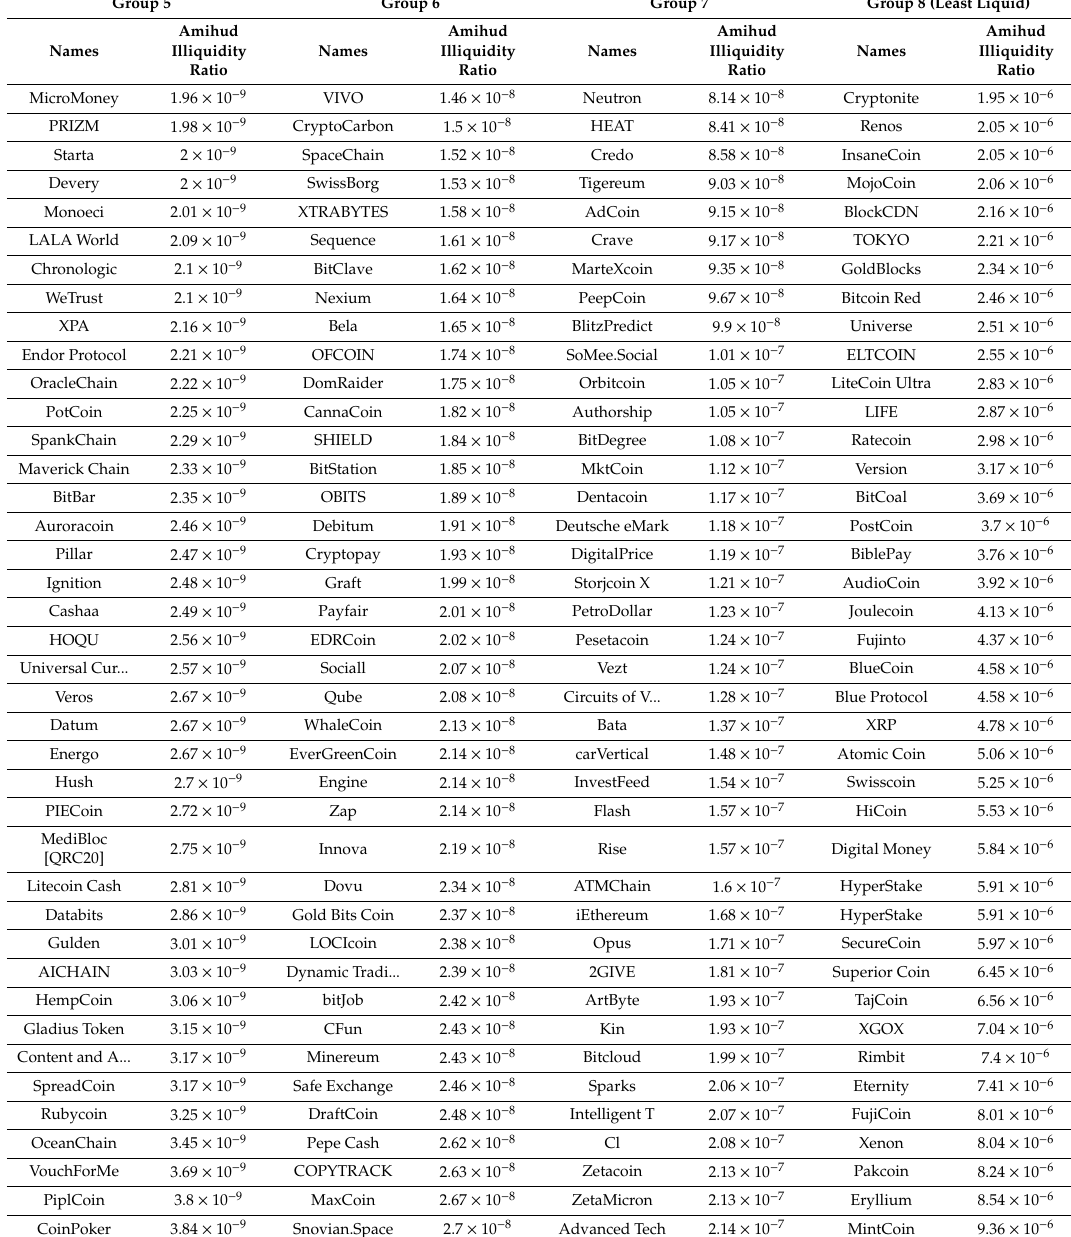
Table 2. Groups of less liquid